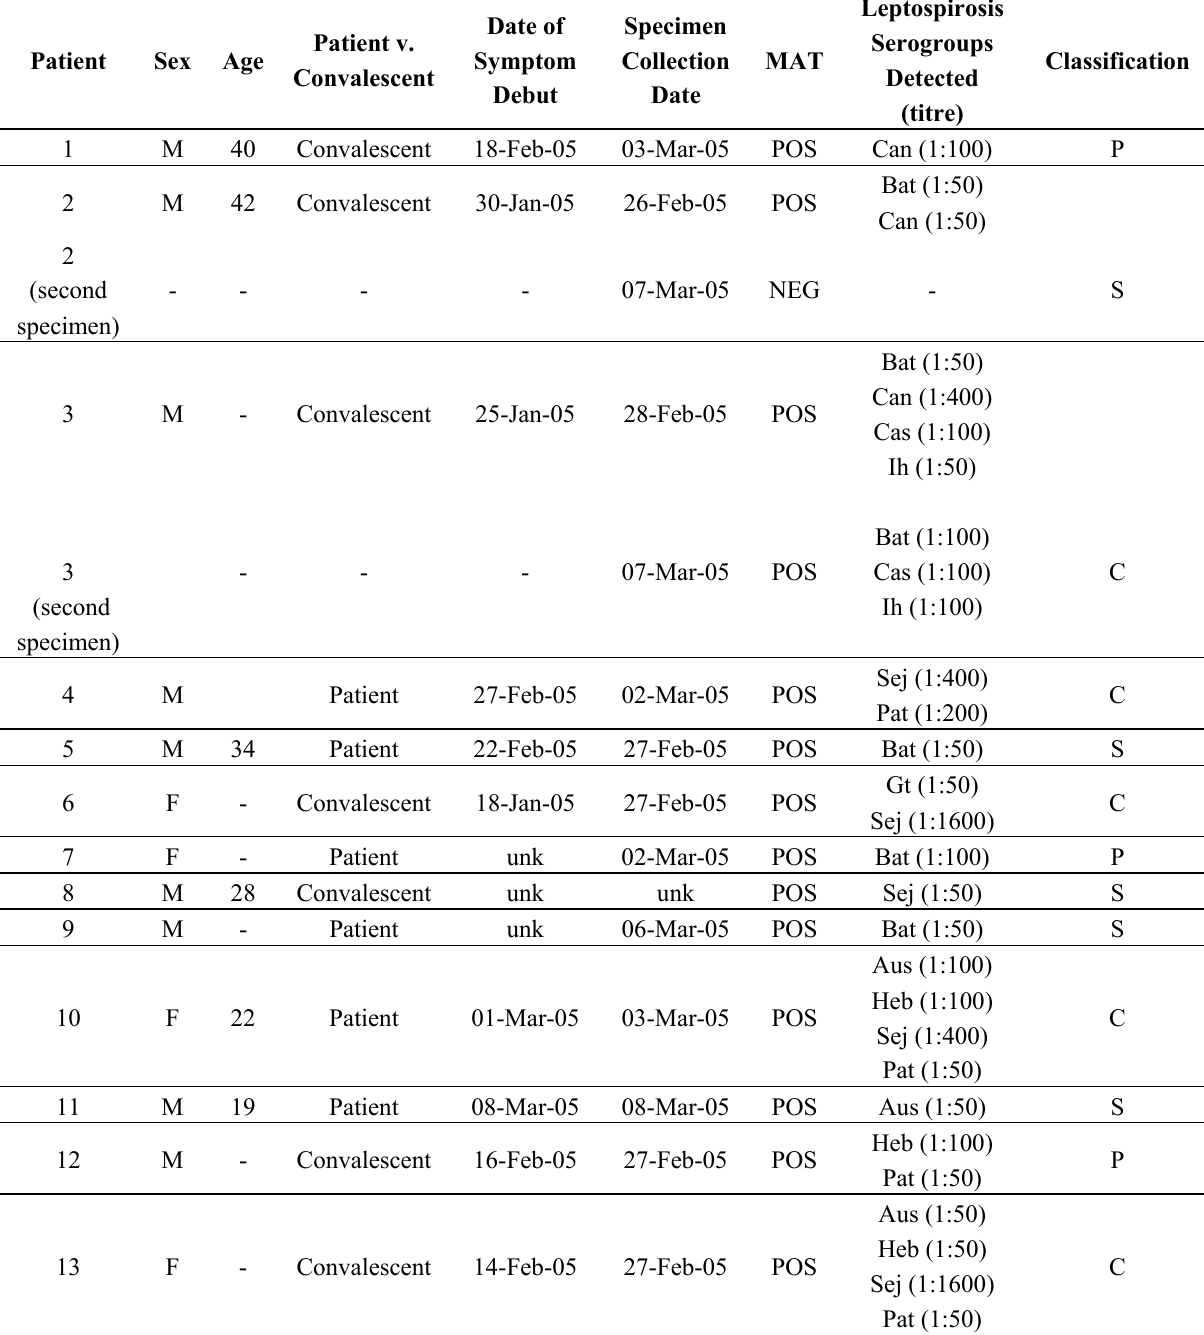
Table 1. MAT results and identified serovars for 29 leptospirosis seropositive patients tested during the pneumonic plague outbreak, DRC,